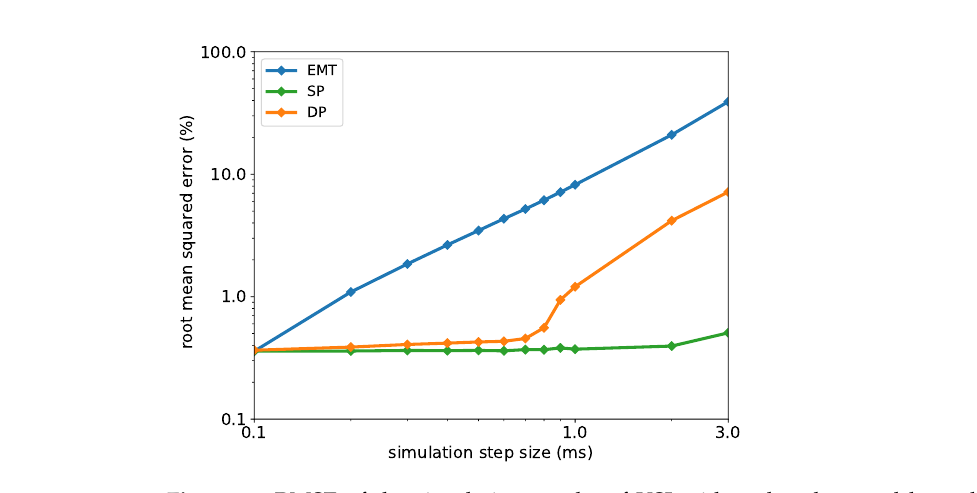
Figure 6. RMSE of the simulation results of VSI with a closed control loop depending on the simulation step size.